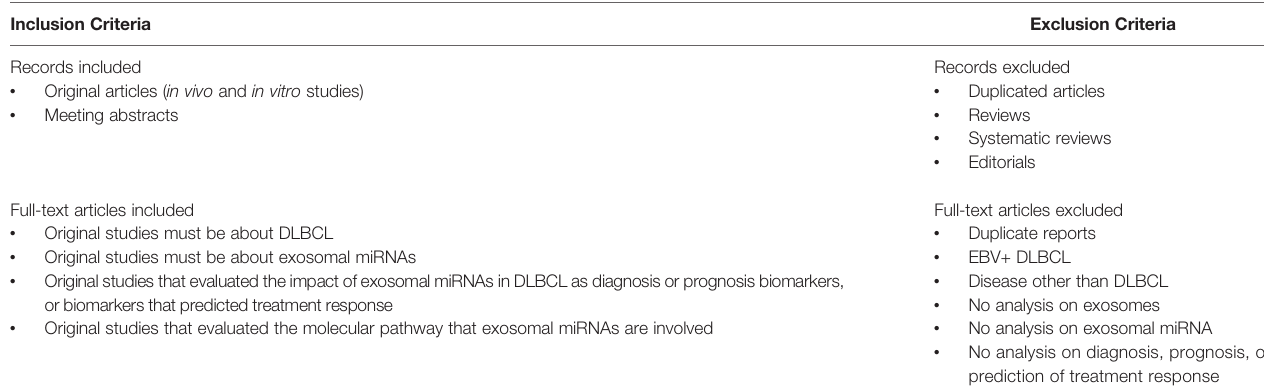
TABLE 2 | Inclusion and Exclusion